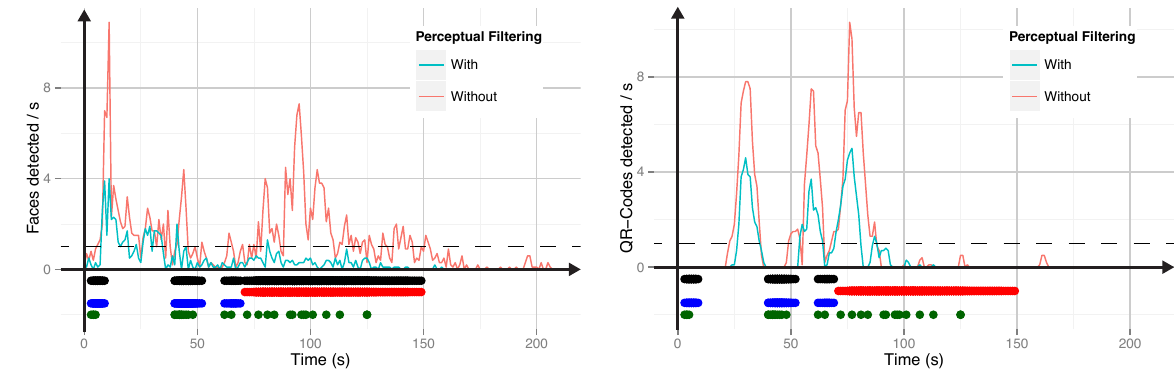
Figure 10: Examples of the effect of perceptual filtering from [22], which show the detection rate per second for faces (left) and QR-Codes (right) with the dash line marking 1 detection per second. The black bars indicate when filtering was applied on faces and QR-Codes. The red bar illustrates when a Strategy for path planning was selected. The blue bars indicate when a Strategy for voice localization was selec- ted, which was triggered by loud noises (green